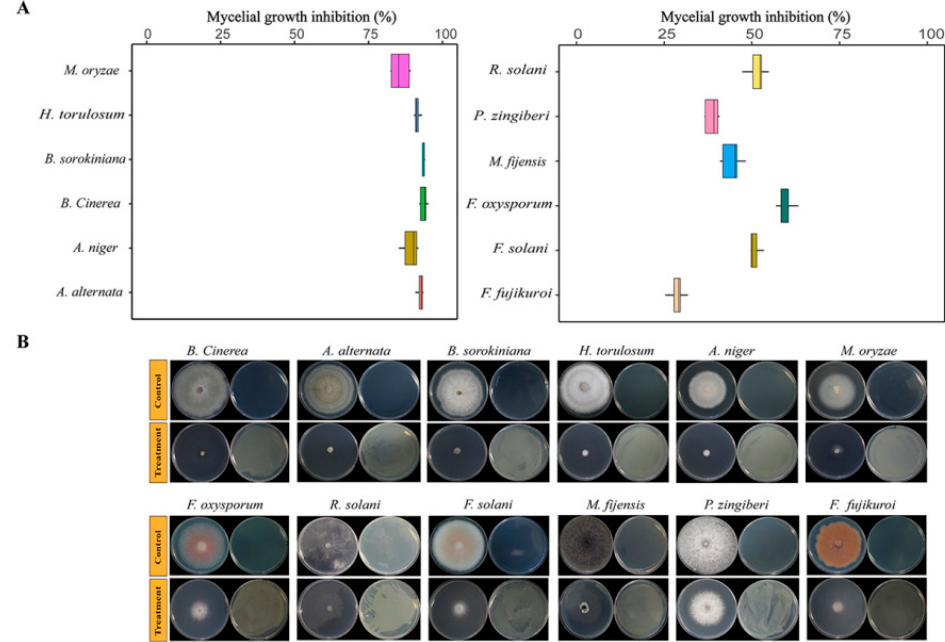
Figure 3. Antifungal effects of the volatile organic compounds produced by ETR-B22. ( A ) Box plots showed the inhibition rates of fungal growth exposure to VOCs produced by ETR-B22. Boxes represented the mean with standard errors of six independent biological replicates. ( B ) Mycelial growth inhibition of fungal pathogens by VOCs produced by ETR-B22.